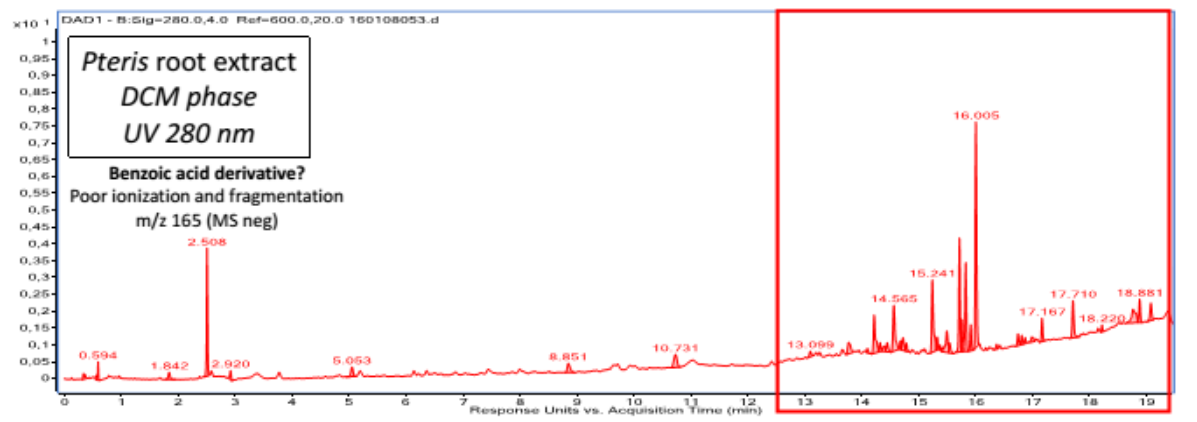
Figure A2. Chemical composition of P. vittata L. roots aqueous fraction from the tape-strips analysis.